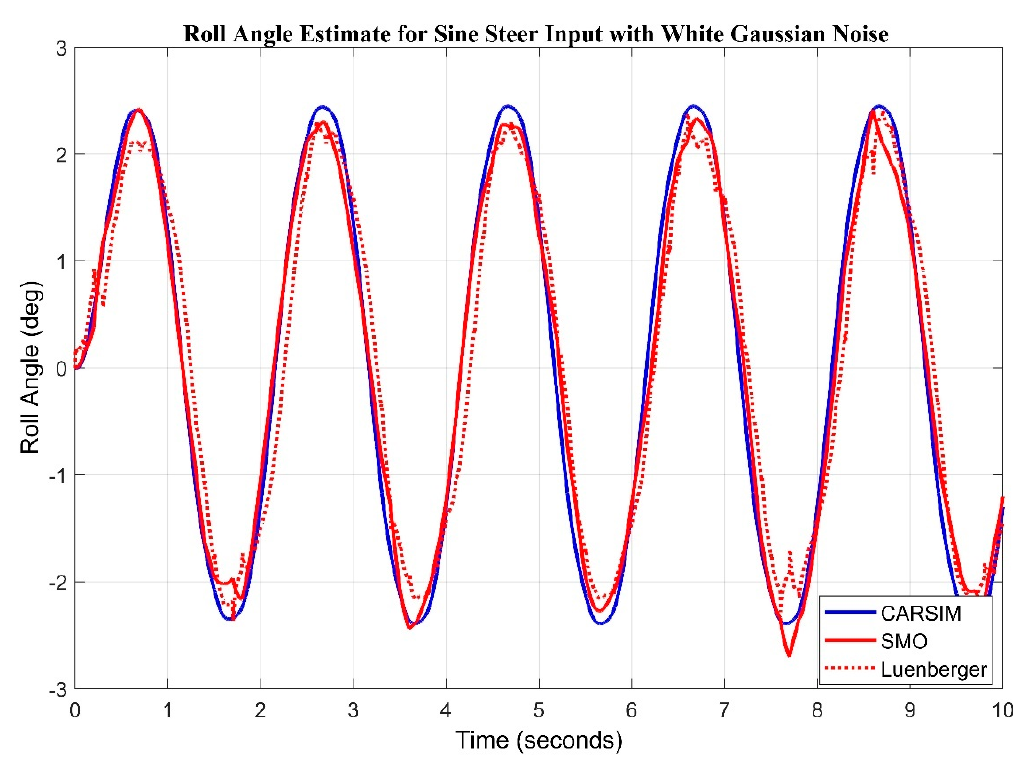
Figure 13. Observer Results for Sine input with Gaussian noise.